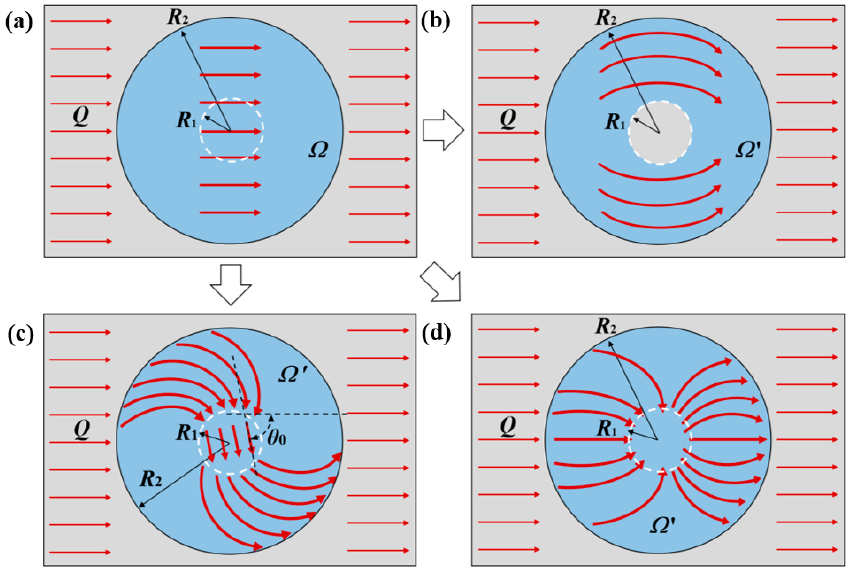
Figure 1. Schematic diagrams of coordinate transformations from an original plane space ( a ), Ω , to a plane space, Ω ’, of thermal cloak meta ‐ structure ( b ), thermal rotation meta ‐ structure ( c ), or ther ‐ mal concentration meta ‐ structure ( d ).